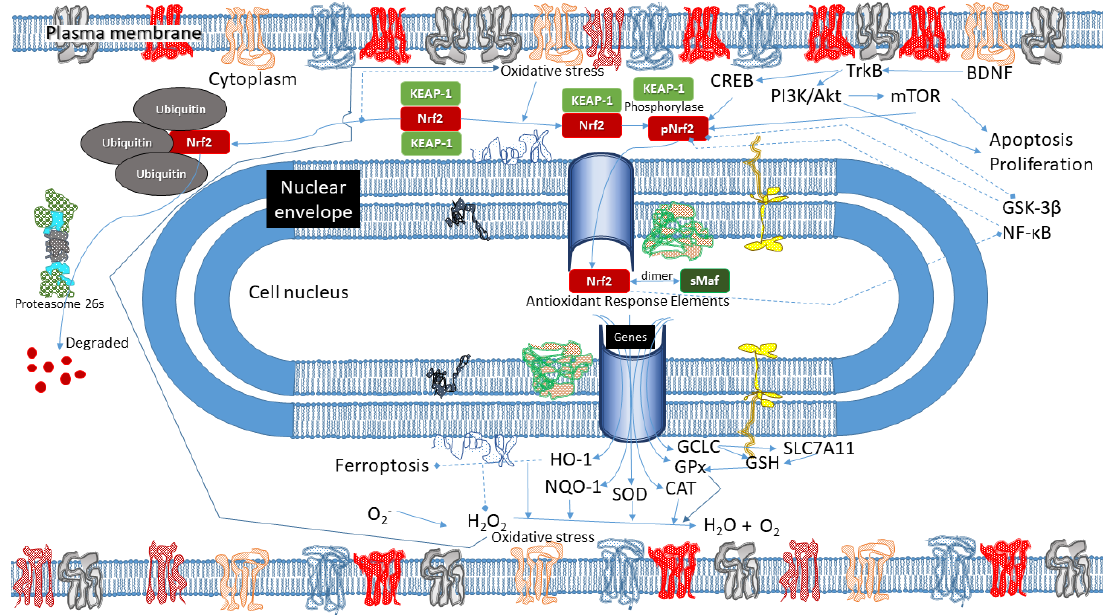
Figure 2. Simplified depiction of the mechanism of action of Nrf2 and the pathways it interacts with. Arrows, activation; broken lines with rhomboid ending, inhibition. Abbreviations . Akt, Protein kinase B; BDNF, brain-derived neurotrophic factor; CREB, cyclic AMP responsive element binding protein; GCLC, Glutamate-cysteine ligase; GPx, glutathione peroxidase; GSH, glutathione; GSK- 3β, glycogen synthase kinase 3-beta; HO-1, haem oxygenase 1; mTOR, mammalian target of rapamycin; NF- κB , nuclear factor kappa B; NQO-1, NAD(P)H quinone dehydrogenase 1; PI3K, phosphatidylinositol-3-kinase; SLC7A11, Solute Carrier Family 7 Member 11 (cystine/glutamate transporter); sMAF, small musculoaponeurotic fibrosarcoma proteins; SOD, superoxide dismutase; TrkB, tropomyosin receptor kinase